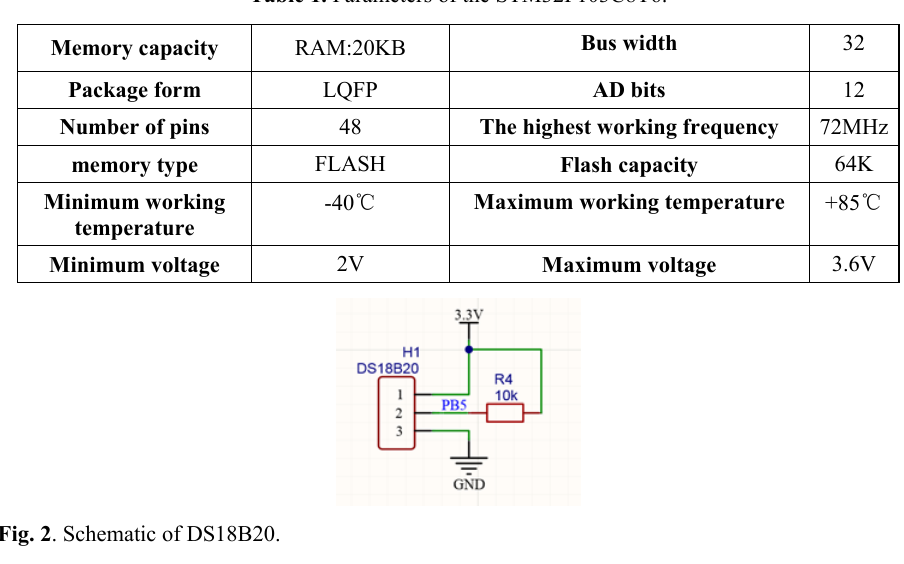
Table 1. Parameters of the STM32F103C8T6.